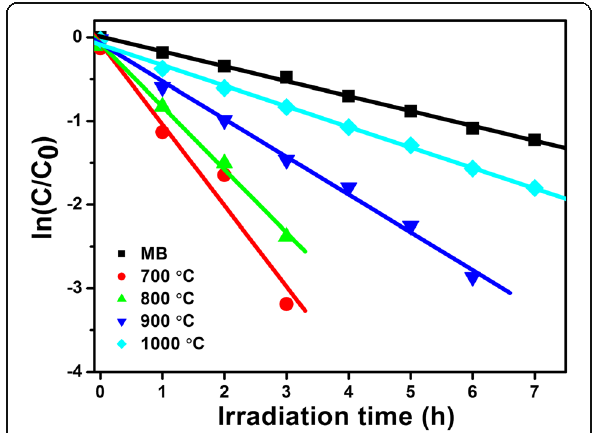
Fig. 6 Kinetic fit for the photo-degradation of MB in the presence of LiNb 3 O 8 powders calcined at different temperatures